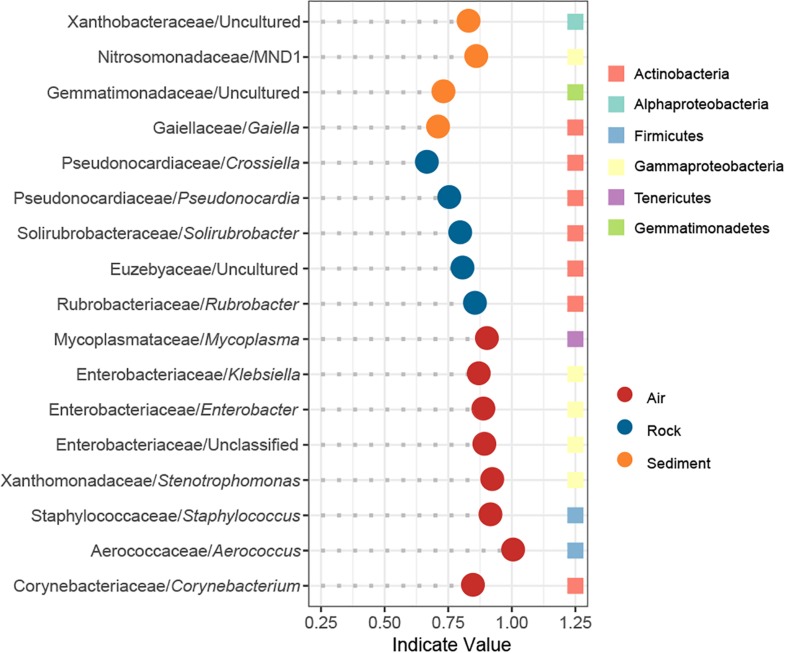
Indicator genera of different cave niches based on an IndVal analysis. Genera with an indicator value >0.6 and p < 0.05 were identified as indicators.